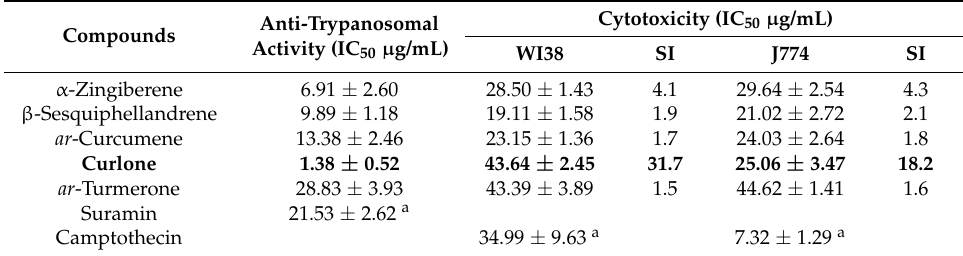
Table 3. Anti-trypanosomal activity and cytotoxicity of five pure compounds identified in C. longa EO.